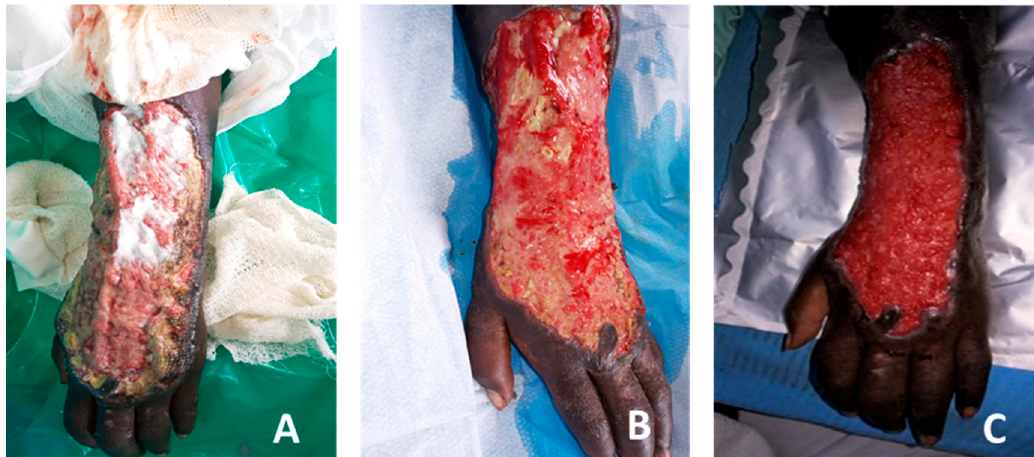
Figure 7. Dramatic improvement of a necrotizing fasciitis arm (Case Report 5). ( A ) Extensive loss of dorsal skin and subcutaneous tissue after necrotizing fasciitis from infected dialysis shunt. After one week of treatment with silver-based cream the wound has pale granulation tissue with lot of fibrin and necrotic tissue. ( B ) After two weeks of COD treatment large islands of red granulation tissue replace the necrotic and fibrinous tissue. ( C ) additional one week of COD results in full dense red granulation tissue. The wound is ready for skin grafting.